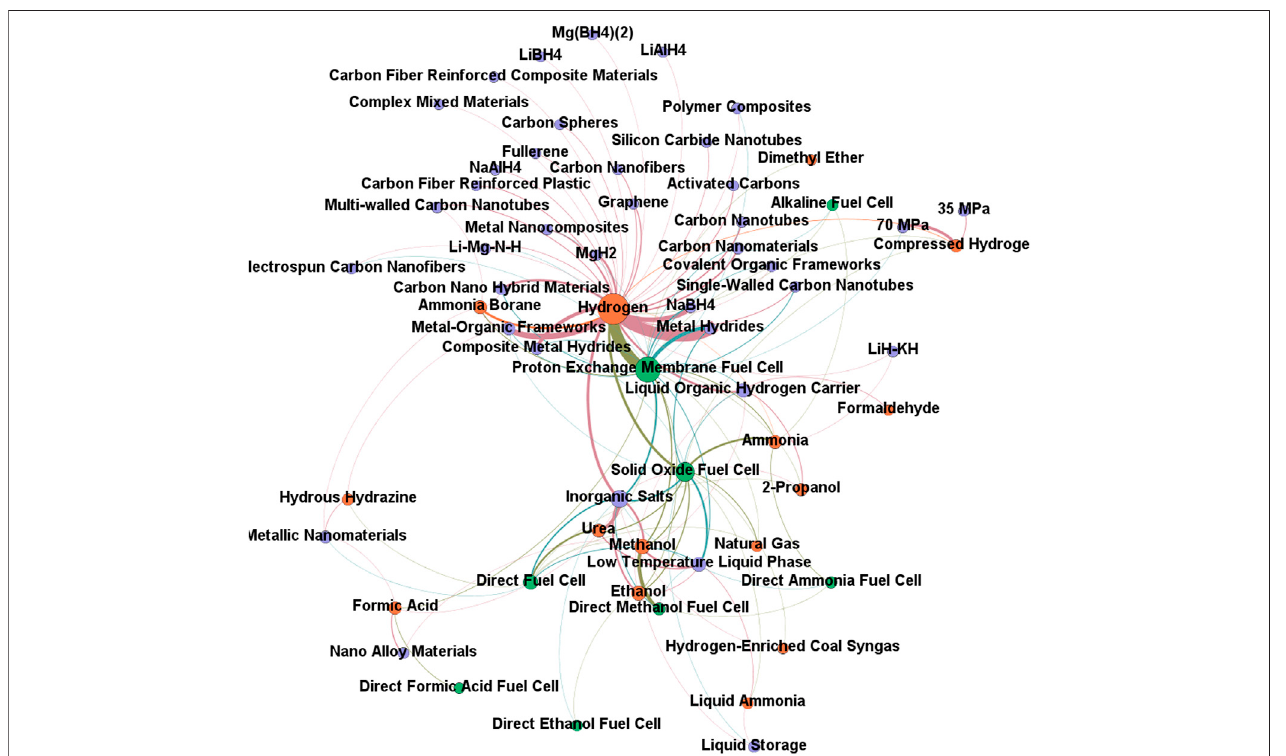
FIGURE 10 | Schematic diagram of the OHSS heterogeneous knowledge network during 2016 – 2019. Note: The number of nodes is 60; The weight of edges is 504; The number of edges is 123.